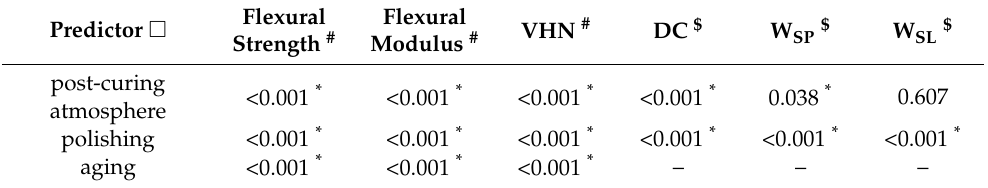
Table 1. p -values acquired by 3- and 2-way ANOVA for the evaluated mechanical properties. Predictor